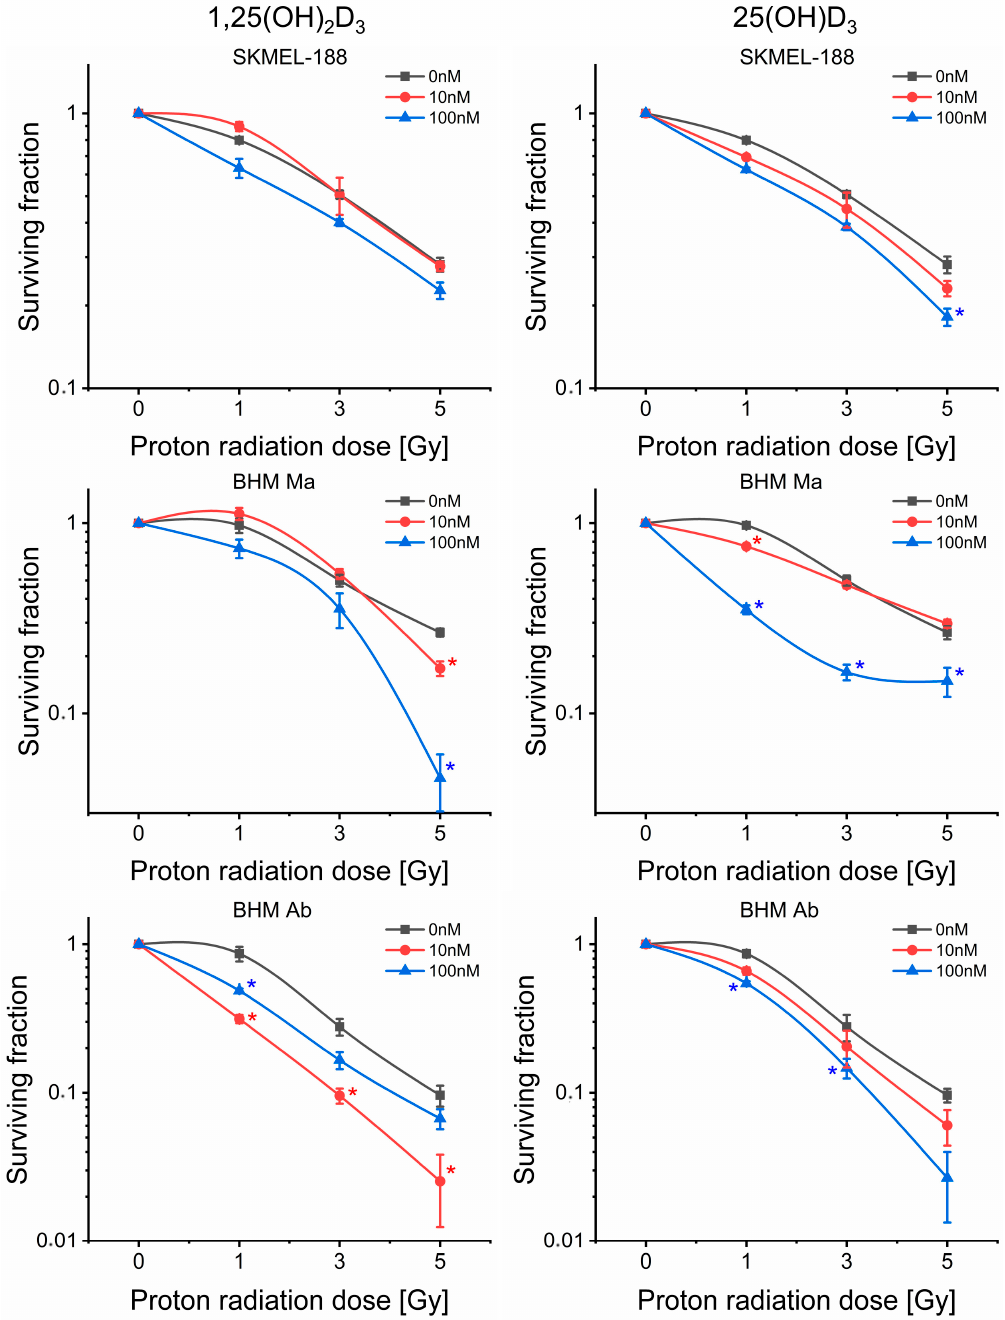
Figure 3. The effect of calcitriol (1,25(OH) 2 D 3 ) and calcidiol (25(OH)D 3 ) on the cellular response to proton beam irradiation of human SKMel-188 and hamster BHM Ma and BHM Ab melanoma cells. Surviving fraction was determined from the model described by Buch et al. [34], based on the experimental data from cell number, counted every 24 h for 4 days in culture after irradiation. * denotes statistical significance p < 0.05 against irradiated control.